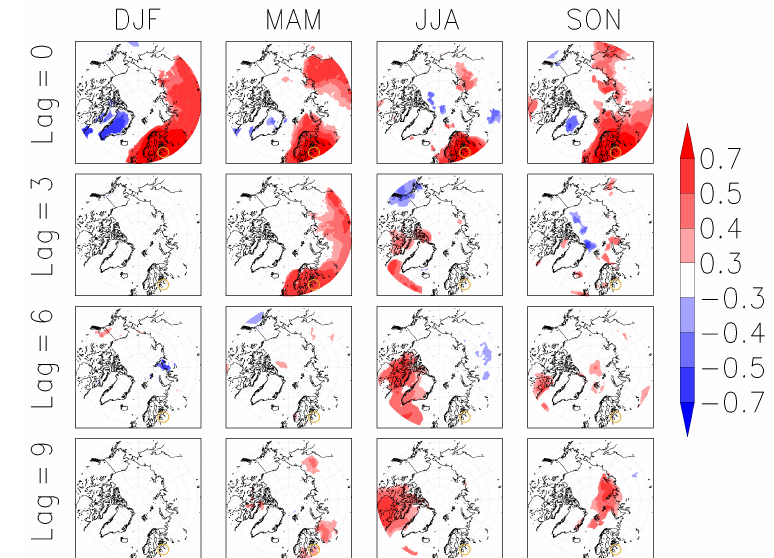
Figure 6. Lagged correlation maps between the TP (the yellow circle) and Arctic 1000hPa temperature: first row, lag is 0 months (no lag); second row, lag is 3 months; third row, lag is 6 months; fourth row, lag is 9 months. Columns represent seasons; all presented correlations are significant at the confidence level